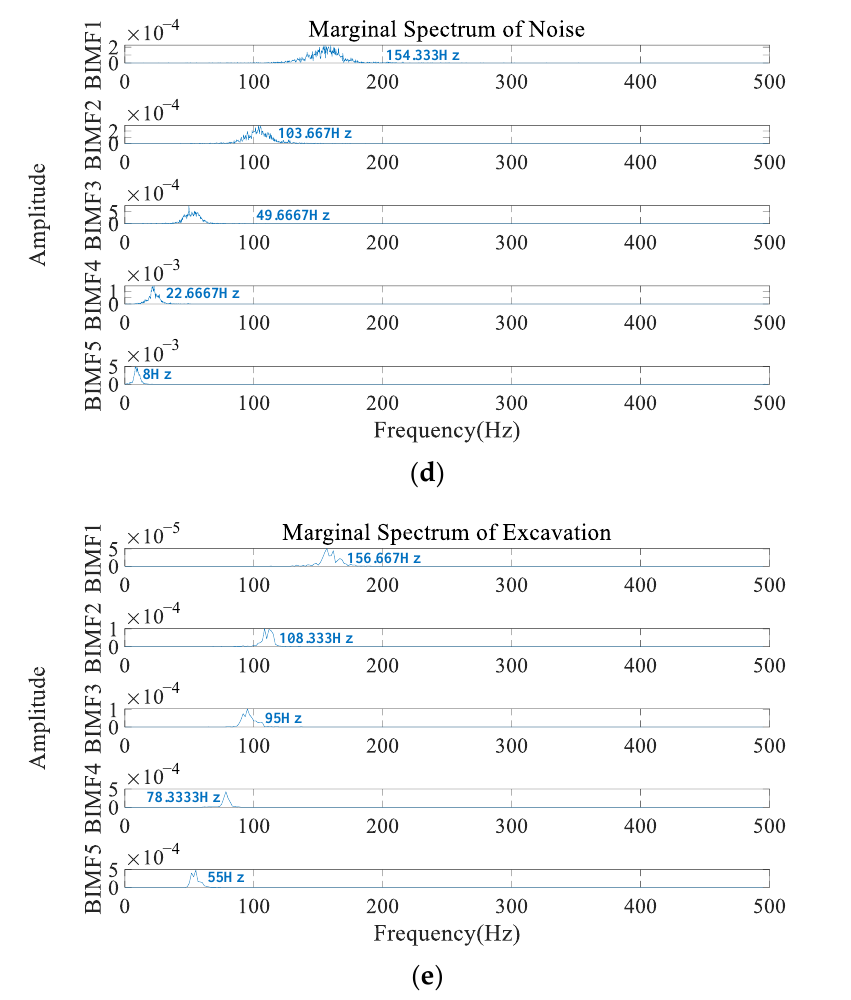
Figure 4. The marginal spectrum dominant frequency from each BIMF component from one of the seismic signals generated by different intrusion activities after variational mode decomposition and Hilbert transform (VMD-HT). ( a ) Bicycle. ( b ) Vehicle. ( c ) Footstep. ( d ) Noise. ( e ) Excavation.